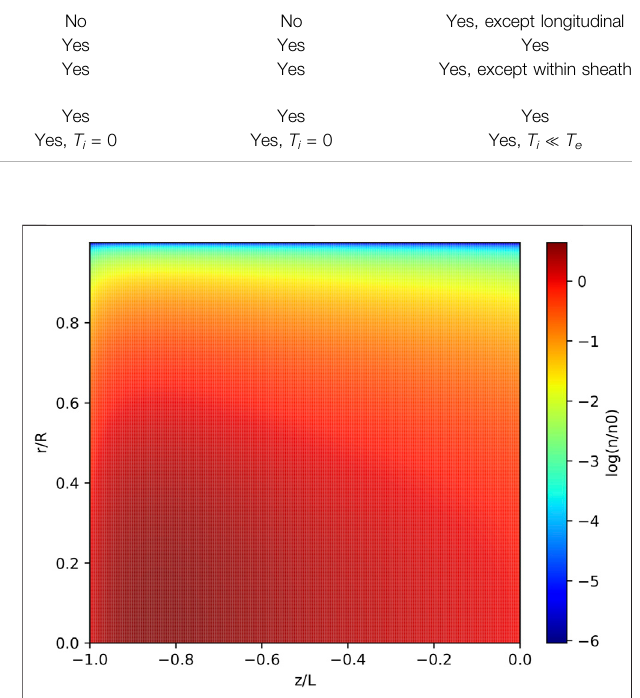
FIGURE 3 | Estimation of 2D plasma density distribution in the VX-CR researchHPS,obtainedthroughthemodeldevelopedbyAhedoetal.[31,32]. Geometry and plasma parameters were obtained from [61, 88, 91]. Density values are normalized with respect to the background neutral